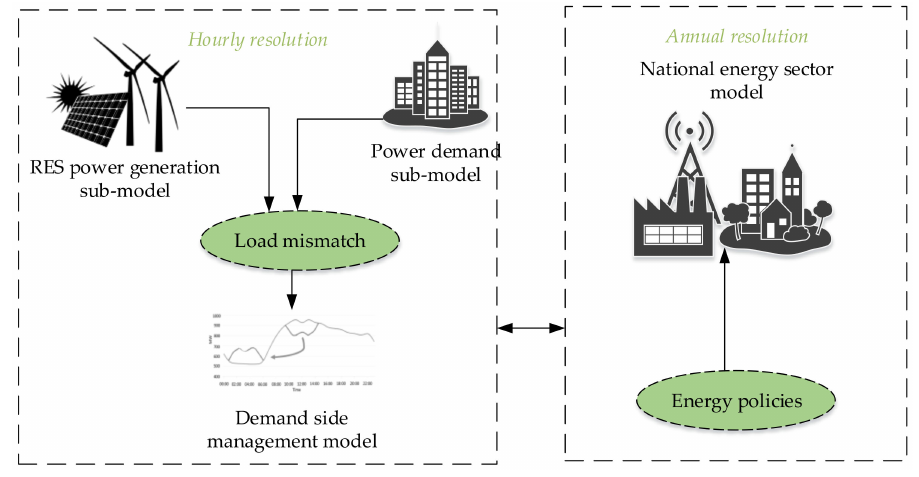
Figure 2. Research